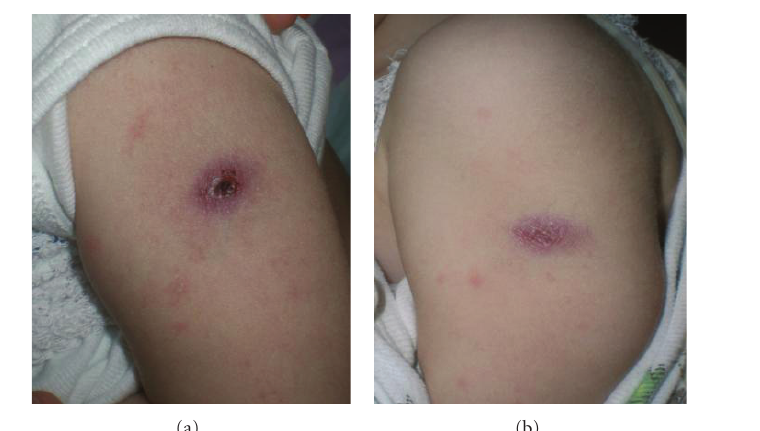
Figure 3: BCG vaccination site at the time of immune reconstitution (a) 5 months after transplantation and (b) 5.5 months after transplantation, showing skin ulceration with massive infiltration of